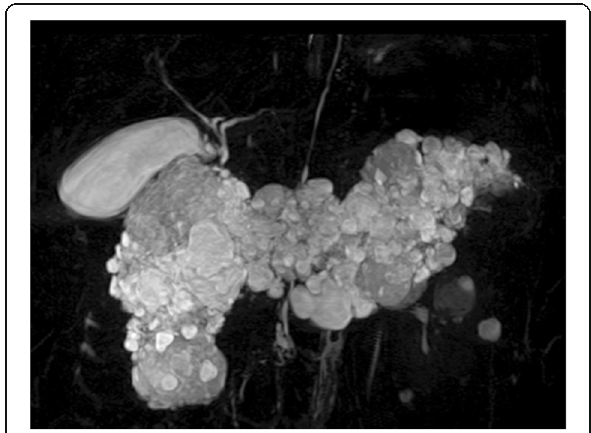
Fig. 2 Magnetic resonance cholangiopancreatography showed innumerable cystic lesions of the whole pancreas and no detectable main pancreatic